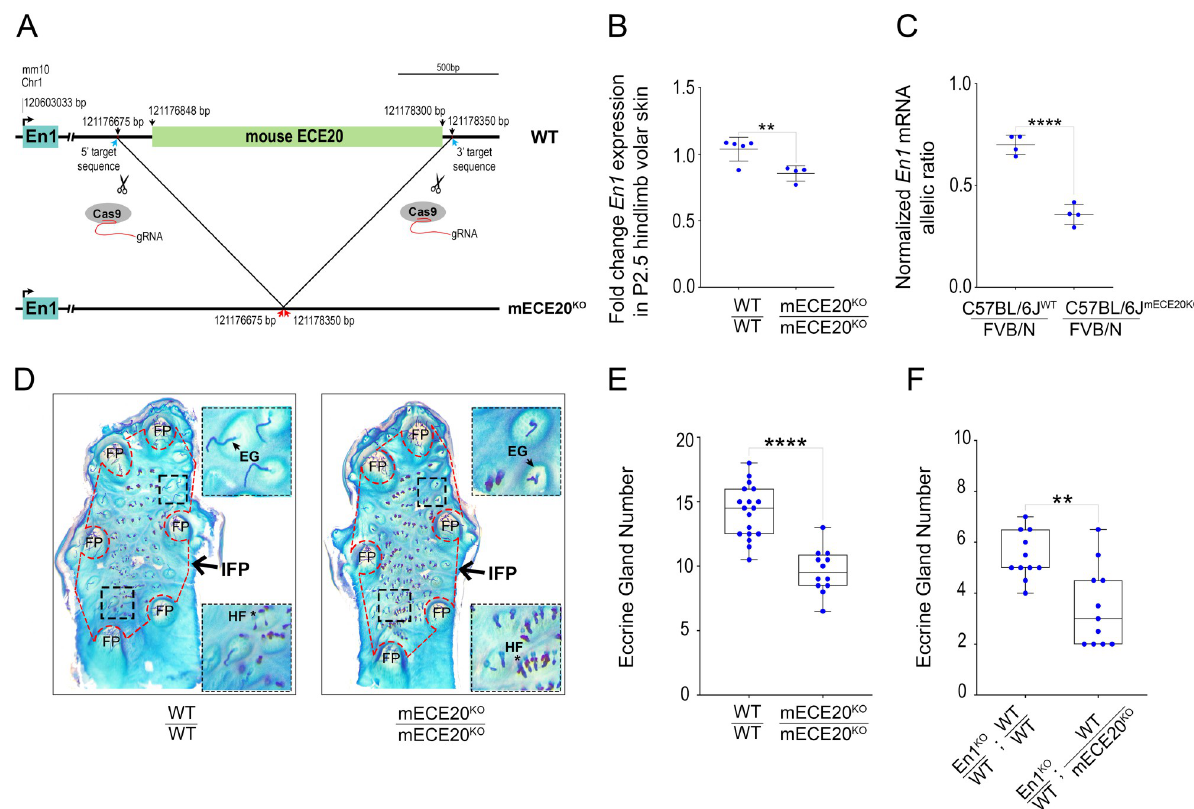
Fig 2. ECE20 potentiates En1 expression to induce the formation of eccrine glands. (A) Strategy to generate mECE20 knock-out (mECE20 KO ) mouse. (B) Fold change in En1 mRNA by qRT-PCR in P2.5 volar hindlimb skin of wildtype (WT / WT), and mECE20 KO homozygote (mECE20 KO / mECE20 KO ) mice relative to mean wildtype value. (C) Normalized En1 mRNA allelic ratio in volar hindlimb skin at P2.5 of wildtype (C57BL/6J WT / FVB/N) and mECE20 KO (C57BL/6J(mECE20 KO ) / FVB/N) hybrid mice. Ratios reported are normalized to the genomic DNA allelic ratio. (D) Representative images of whole mount preparations of the volar hindlimb skin from WT / WT and mECE20 KO / mECE20 KO adult mice. Epidermal preparations were stained to facilitate quantification of appendages in the interfootpad area (IFP, outlined in red dashed border). Insets show magnified views of regions within the IFP (black dashed border). Footpad (FP), eccrine gland (EG) and hair follicles (HF). (E) Quantification of IFP eccrine glands in the hindlimb volar skin of WT / WT and mECE20 KO / mECE20 KO mice. (F) Quantification of IFP eccrine glands in En1 KO / WT; WT / WT and En1 KO / WT; WT / mECE20 KO mice. In (B, C) each dot represents the mean value for an individual biological sample. In (E, F) each point represents the average number of eccrine glands in the IFP across both hindlimbs of a single mouse. In (B, C) mean (line) with standard deviation are plotted. In (E, F) the median (line) and maximum and minimum are reported for each genotype. In (B, C, E, F) significance assessed by a two-tailed T-test. ���� P < 0.0001, �� P < 0.01. (KO) knock-out. In (B) Rlp13a was used as a housekeeping transcript for normalization. See also S2 Fig.